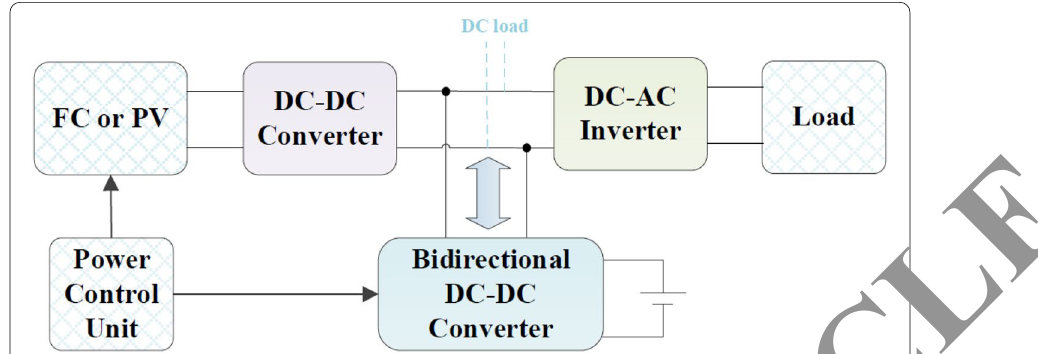
Fig. 4 The bidirectional DC-DC converter in FC or PC systems